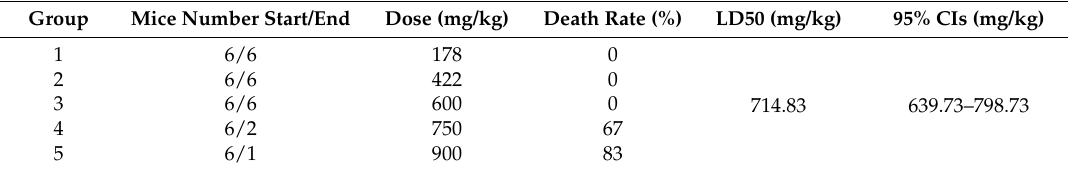
Table 3. Results of Oxy-Di-OA on mortality of the acute toxicity test via intraperitoneal injection in mice. Group Mice Number Start/End Dose (mg/kg) Death Rate